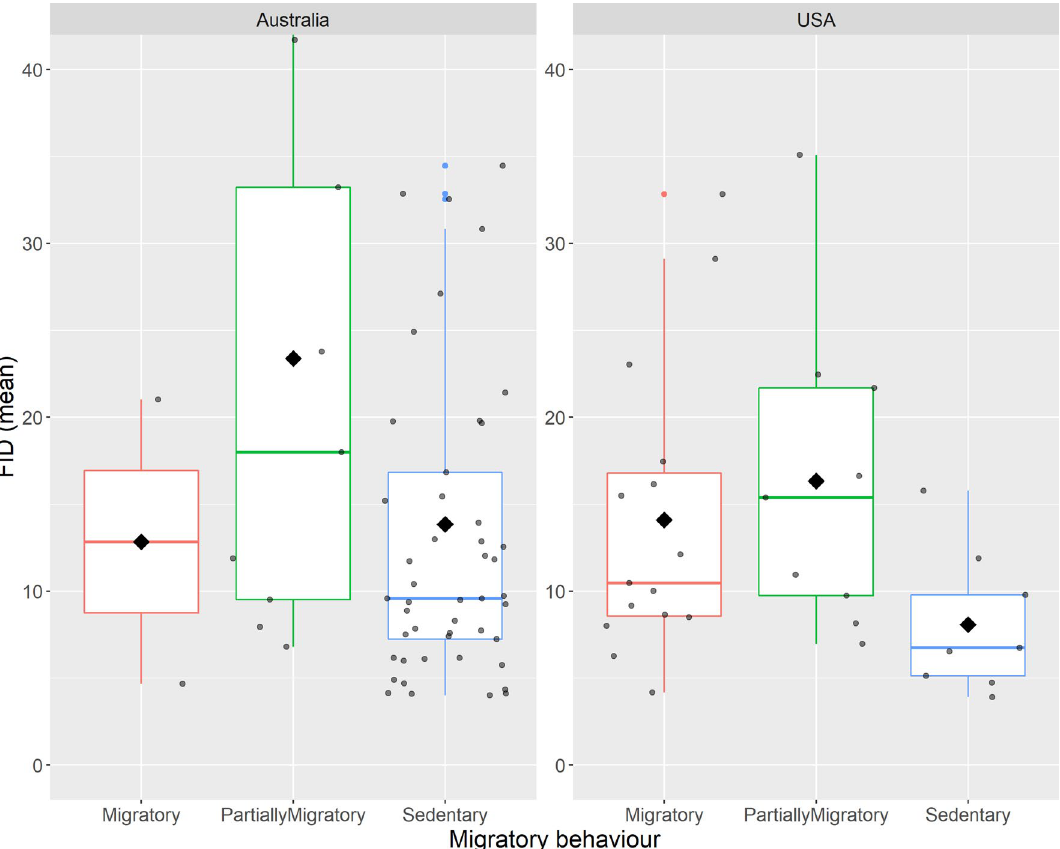
Figure 1. Difference in flight initiation distance (FID in metres) among migratory, partially migratory and sedentary birds, split by country where data were collected. The box plots show medians (horizontal bar), quartiles, 5- and 95-percentiles, jittered points (small-grey dots) and extreme values (small-coloured dots). Mean values are indicated with black